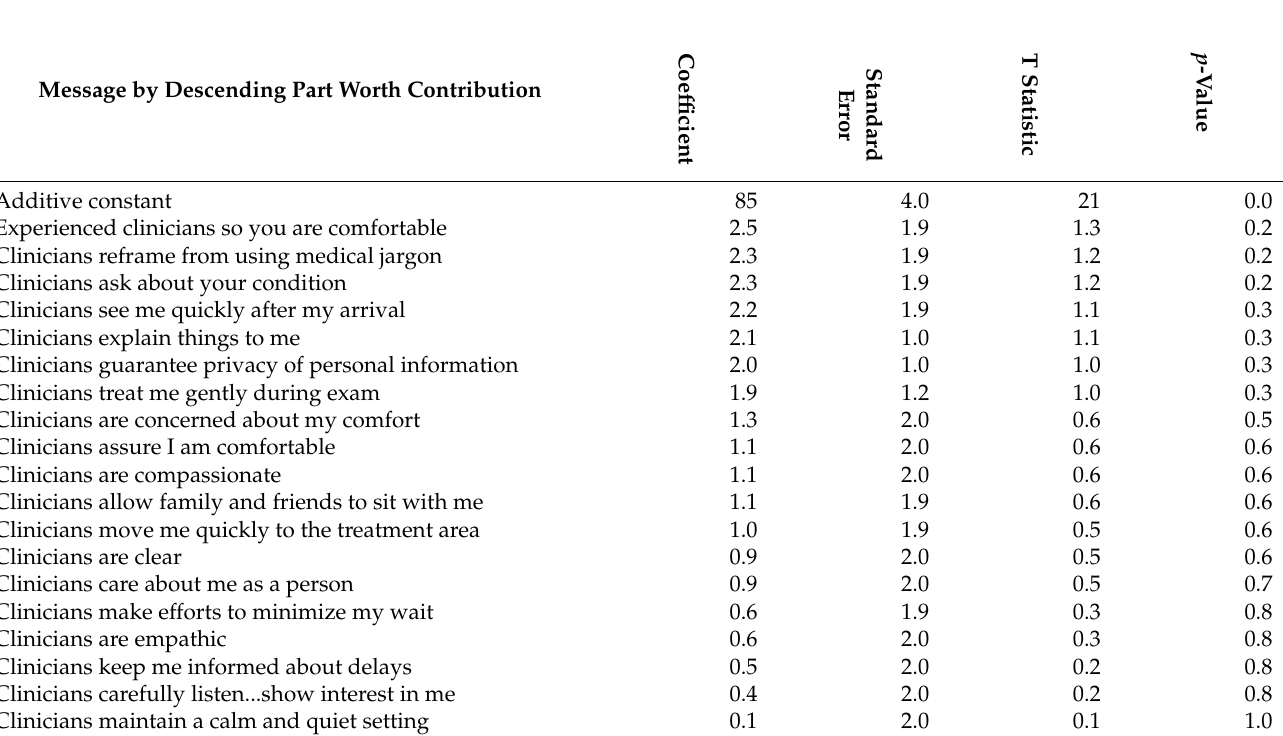
Table 3. The Power of all 36 Messages as Drivers of Patient Satisfaction in the Total